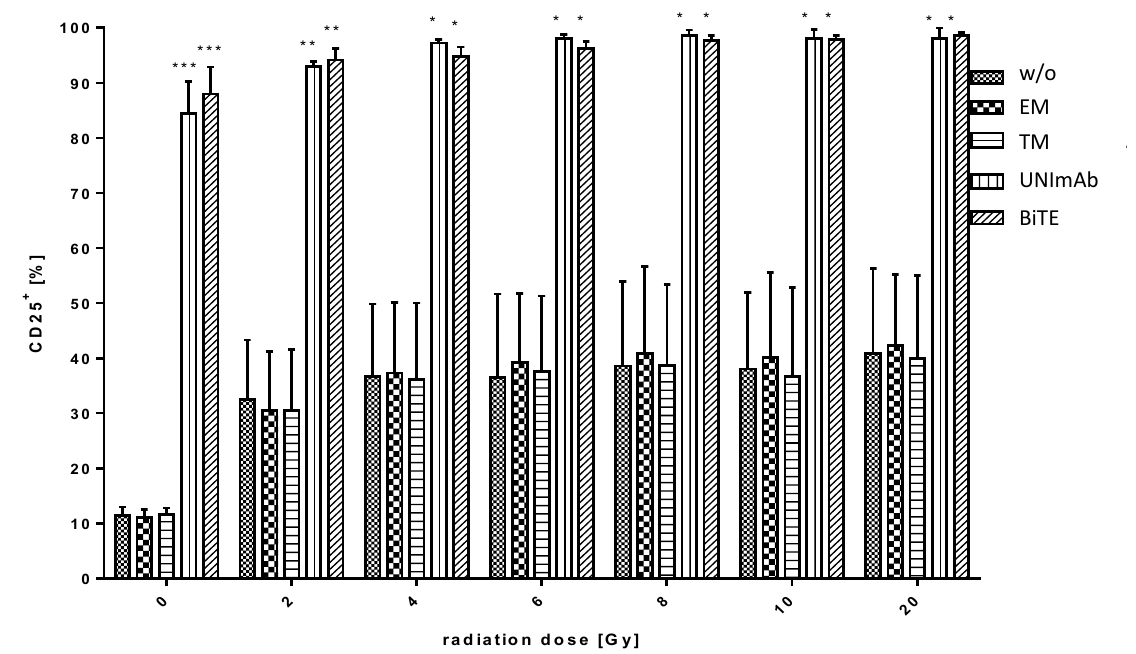
Figure 3. Retargeting of tumor cells with irradiated T cells. Estimation of T cell activation. Pan T cells were irradiated with up to 20 Gy and redirected to PSCA overexpressing PC3 cells either in the absence (w/o) or presence of 30 pmol/mL of the respective Ab components (effector module alone (EM), target module alone (TM), UNImAb complex (UNImAb), conventional BiTE (BiTE)). The pan T cells were incubated with the PC3-PSCA cells for 5 d. Afterwards cells were stained for the expression of the activation marker CD25. The expression level was measured by FACS analysis. Redirection of the T cells resulted in an upregulation of CD25 via both the conventional BiTE and the UNImAb format. Summarized data of three individual donors are shown. (* p < 0.05; ** p < 0.01 and *** p < 0.001 in relation to controls w/o Ab; one-way ANOVA, Bonferroni Multiple Comparison test).